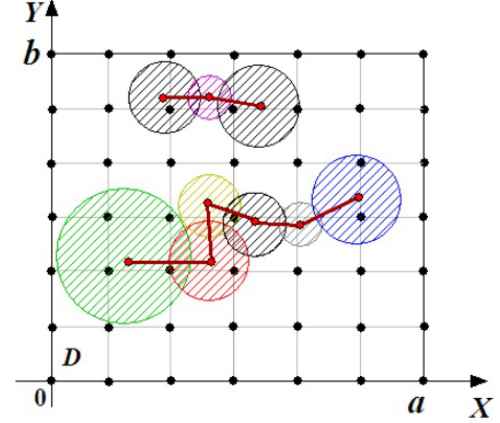
Fig. 11 Multiple point random